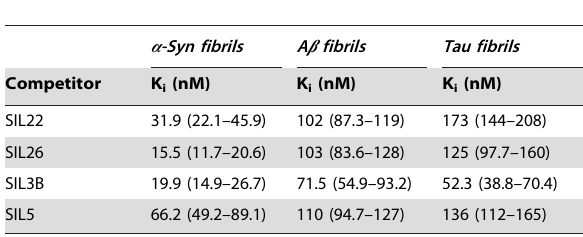
Table 1. Comparison of K i values for SIL analogues in assays with a -syn, A b 1–42 , and tau fibrils illustrates relative selectivity for a -syn over A b 1–42 and